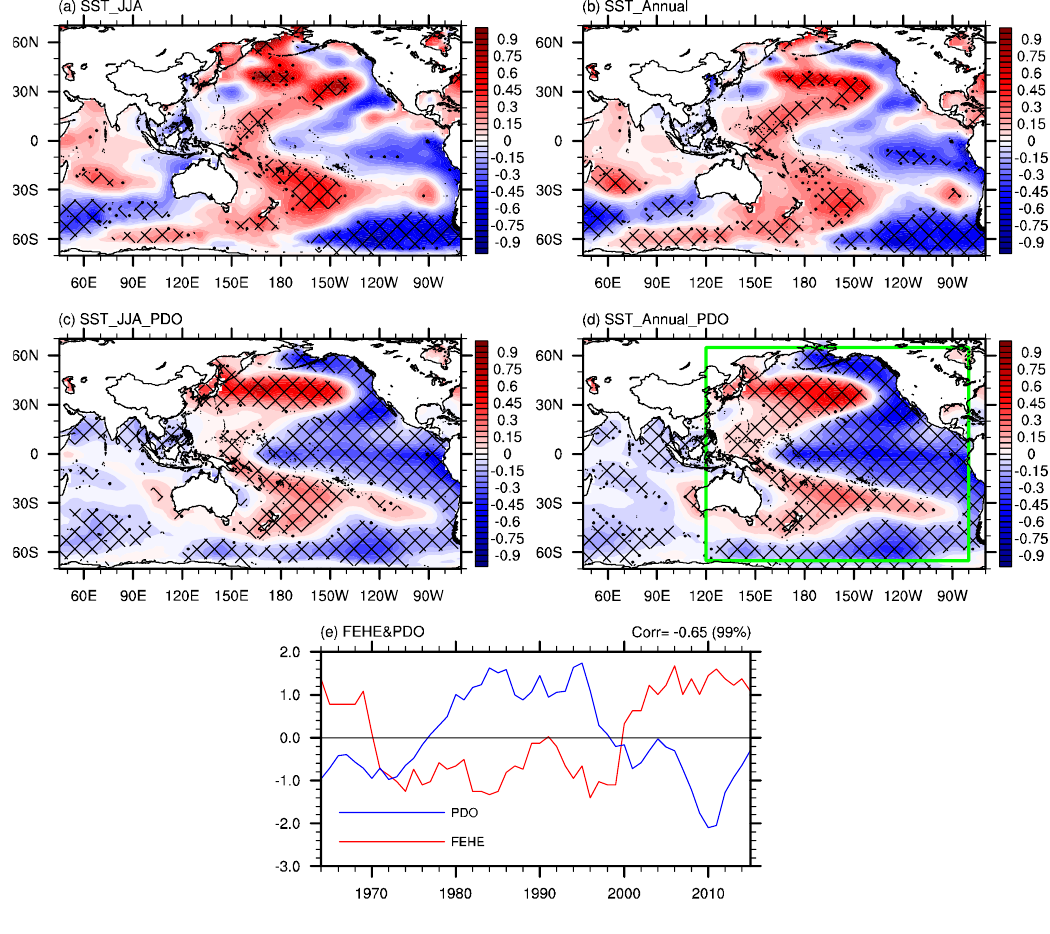
Figure 10. The differences in ( a ) the summer mean sea surface temperature (SST, unit: °C) and ( b ) annual mean SST (unit: °C) between P2 and P1 (P2 minus P1). ( c ) The anomalies of the summer mean SST (unit: °C) regressed on the time series of the summer mean sign–reversed Pacific decadal oscillation (PDO) index. ( d ) The anomalies of the annual mean SST (unit: °C) regressed on the time series of the annual mean sign–reversed PDO index. ( e ) The standardized time series of the 7–year running mean of the summer mean PDO index (blue) and regional FEHE over southern China (red). Dots and meshes in ( a – d ) denote where the anomalies are significant at the 90% and 95% confidence levels based on Student's t test, respectively. The green rectangle in ( d ) refers to the area, the SST anomalies in which are used in the CAM5 (Version 5 of the Community Atmospheric Model) sensitivity experiment.